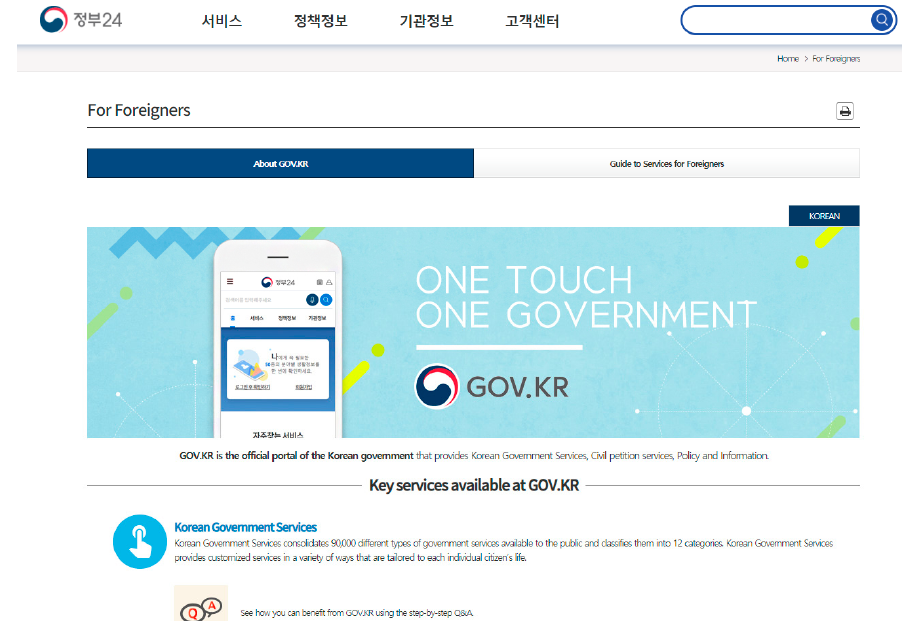
Figure 9. Government 24 System.